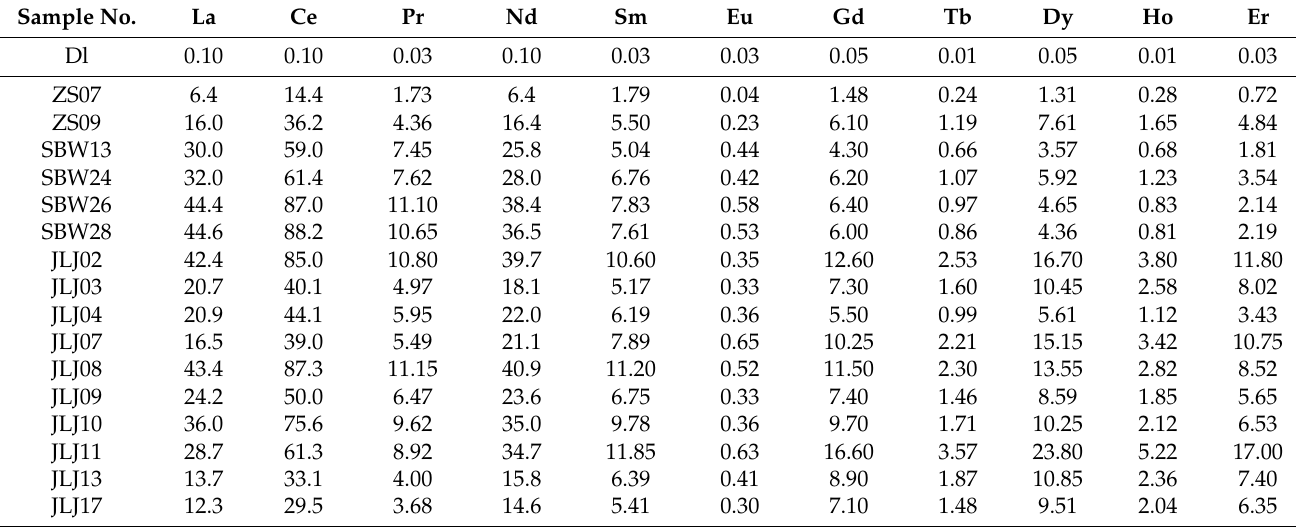
Table A3. REE contents (ppm) and parameters of SJOF granite